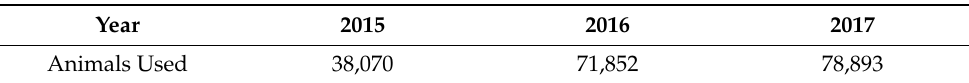
Table 1. The number of animals used in research procedures 1 with the aim of “preservation of species” in the EU Member States